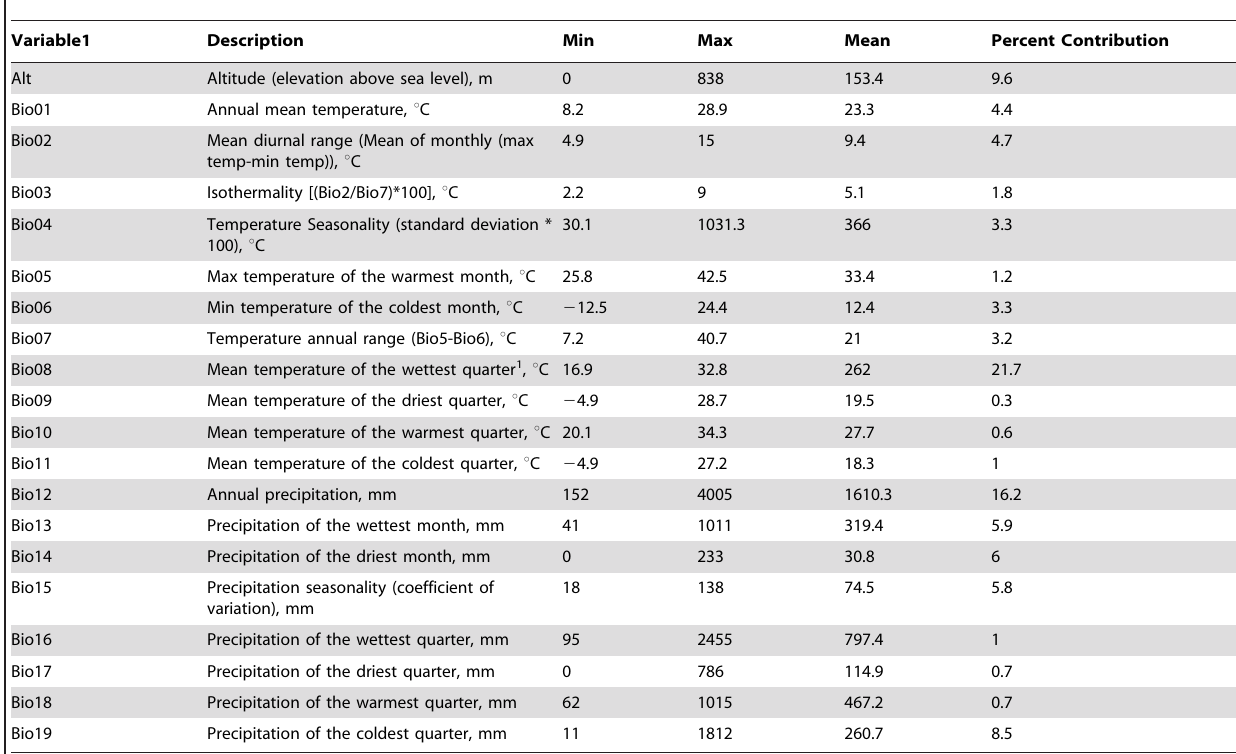
Table 2. Minimum, maximum, mean values and percent contribution of environmental data layers for Cx. tritaeniorhynchus model.